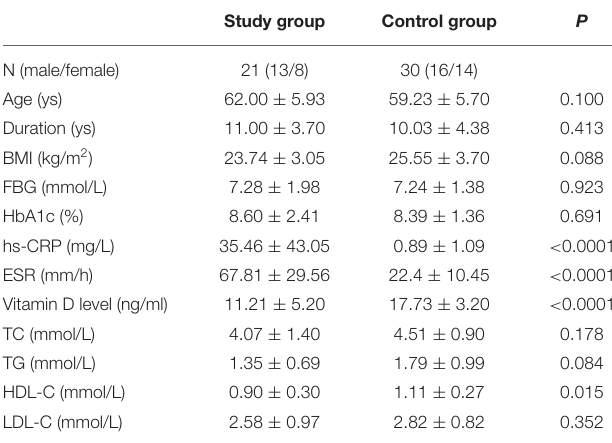
TABLE 1 | Clinical characteristics of the